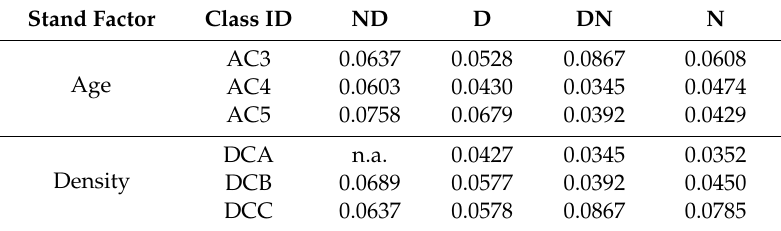
Table 6. Estimates of damage probability in relation to the part of the day, age class (AC) and density class (DC).